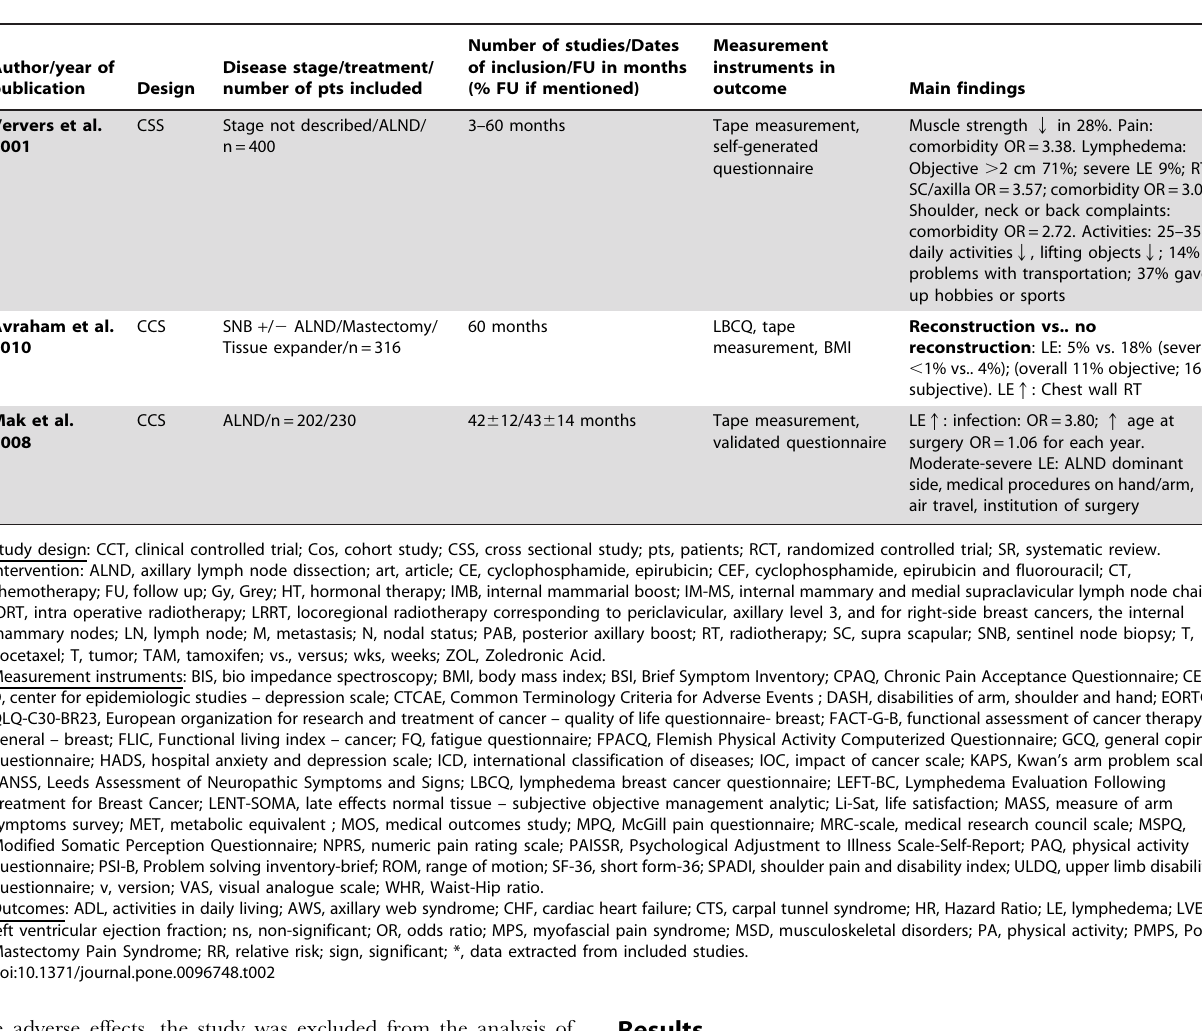
Table 3. Oxford Centre for Evidence-Based Medicine, 2011 Levels of Evidence for common harms (Treatment harms).